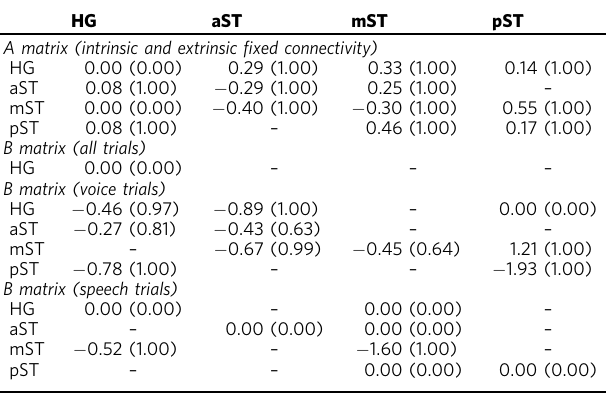
Table 3 Results of the PEB analysis for the right AC